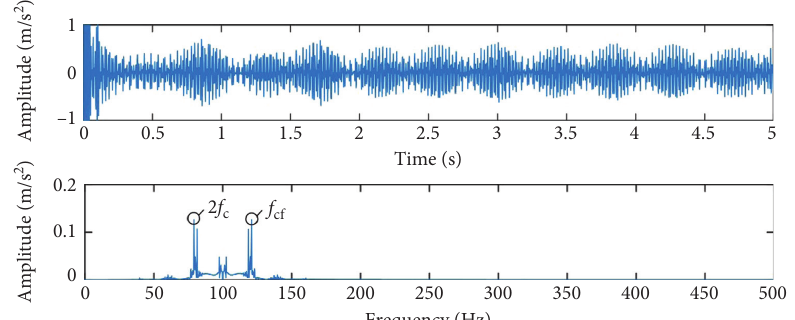
Figure 11: Signal processed by USSR.